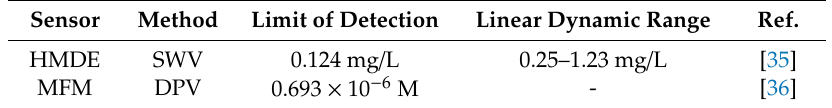
Table 4. A number of characteristics of the Mercury-based electrode in VEN electrochemical